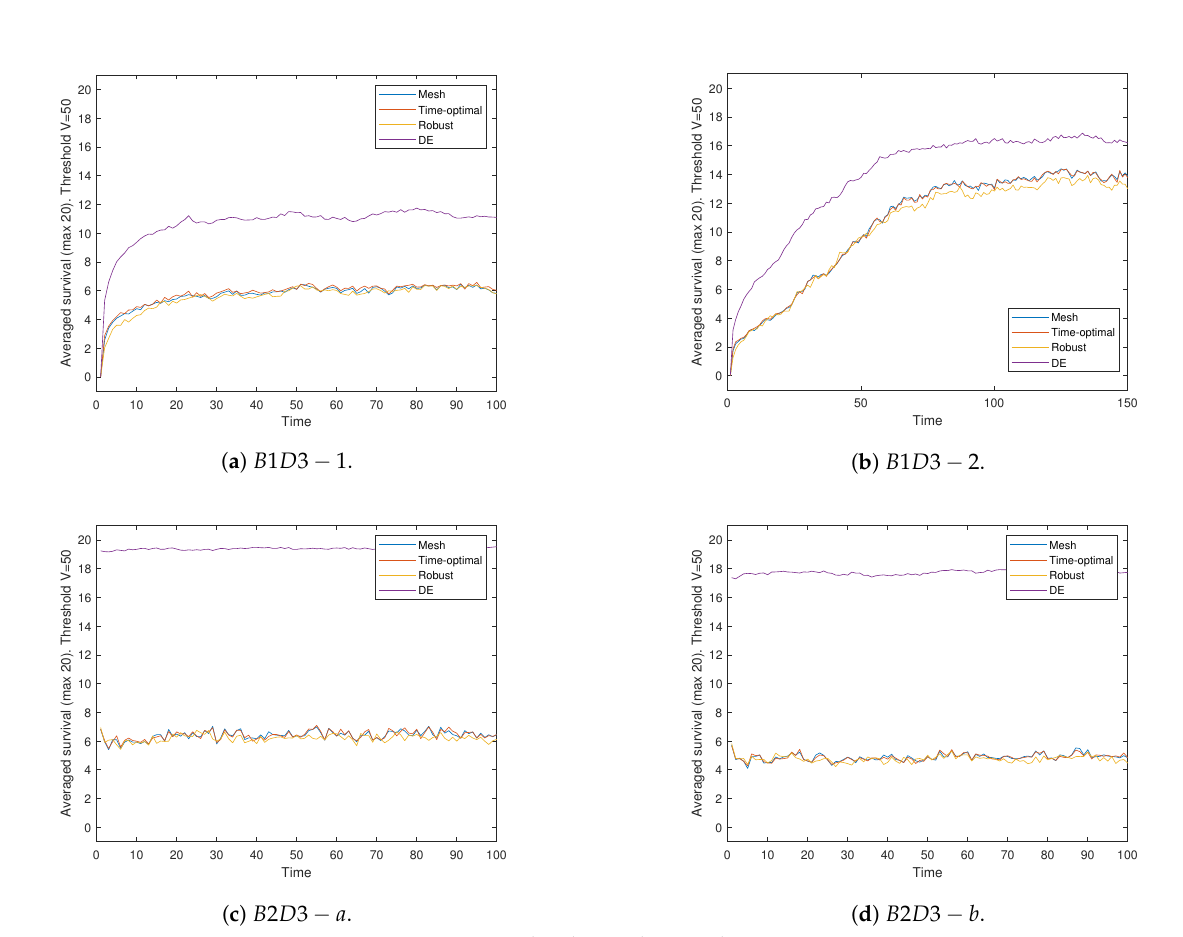
Figure 8. Results obtained using dynamic